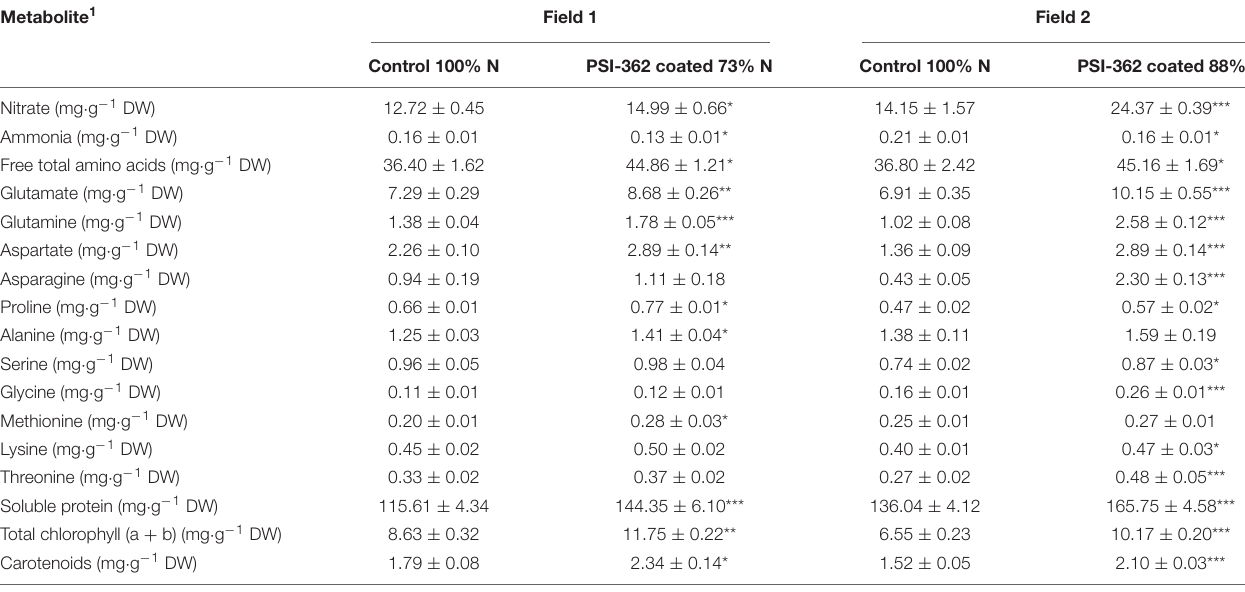
1 Data are the means ± SE. Number of biological replicates (n ≥ 4). Difference between control and treated sample within the same field was significant at *p ≤ 0.05, **p ≤ 0.01, and ***p ≤ 0.001, respectively (t-test).